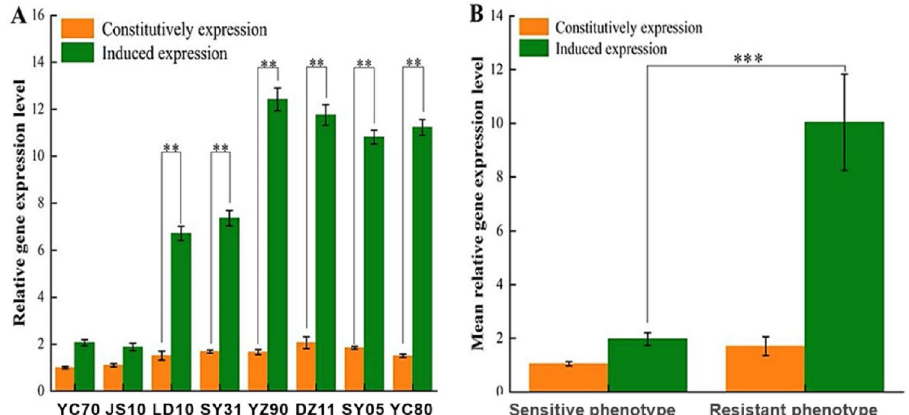
Figure 5. Expression of Ltcyp51 in the sensitive and resistant isolates of Lasiodiplodia theobromae before and after treated by difenoconazole . ( A ) Changes of relative expression levels of 8 isolates; ( B ) changes of the mean relative expression levels of different phenotype. **represent significant level ( P < 0.01), ***represents significant level ( P <